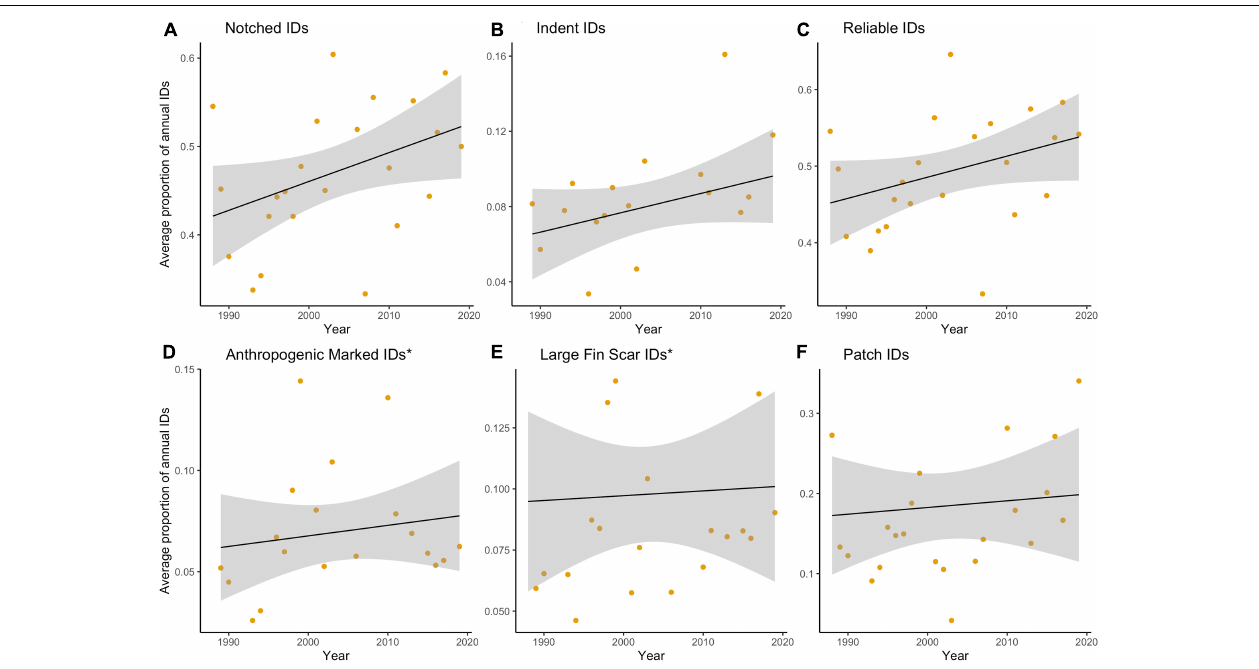
FIGURE 8 | Annual proportion of marked individuals (all ID sides) 1988–2019 for (A) notches, (B) back indents, (C) all reliable marks, (D) anthropogenic scars, (E) large fin scars, and (F) patches. Black line is GLM trend for average proportion by year, gray shading indicates standard error. *Note that GLMs for anthropogenic or fin scar mark types did not show strong support for an increasing trend. Scale of y -axis differs between mark type trend